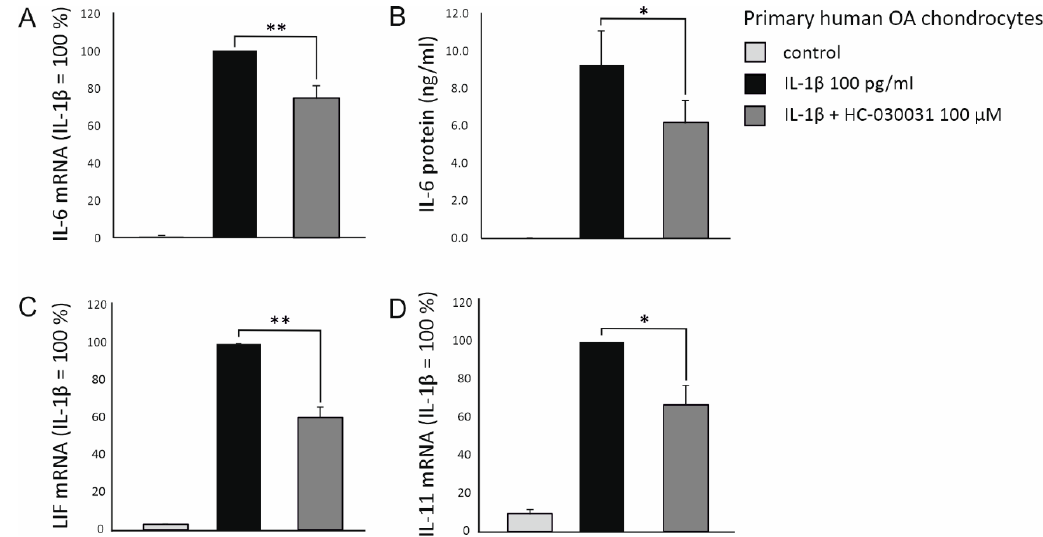
Figure 3. IL-1 β -enhanced expression of IL-6 ( A , B ), leukemia inhibitory factor ( LIF ) ( C ) and IL-11 ( D ) in primary human osteoarthritic (OA) chondrocytes is attenuated by pharmacological inhibition of TRPA1. Primary human OA chondrocytes were stimulated with IL-1 β (100 pg/mL) in the presence and absence of the selective TRPA1 antagonist HC-030031 (100 µ M) for 24 h, after which the cell culture media were collected, and total RNA was extracted. IL-6 was measured from the cell culture medium with immunoassay, and IL-6 , LIF and IL-11 mRNA was measured by qRT-PCR and normalized against GAPDH mRNA levels. The results are expressed as mean + SEM, n = 7. Samples were obtained from seven patients and the experiments were carried out in duplicate. Paired t-test was used in the statistical analysis; * p < 0.05 and ** p < 0.01. (Adapted from the doctoral dissertation of the first author [28]). Table 2. Genes putatively explaining the differential expression of IL-6 production according to Gene Ontology (GO) analysis.